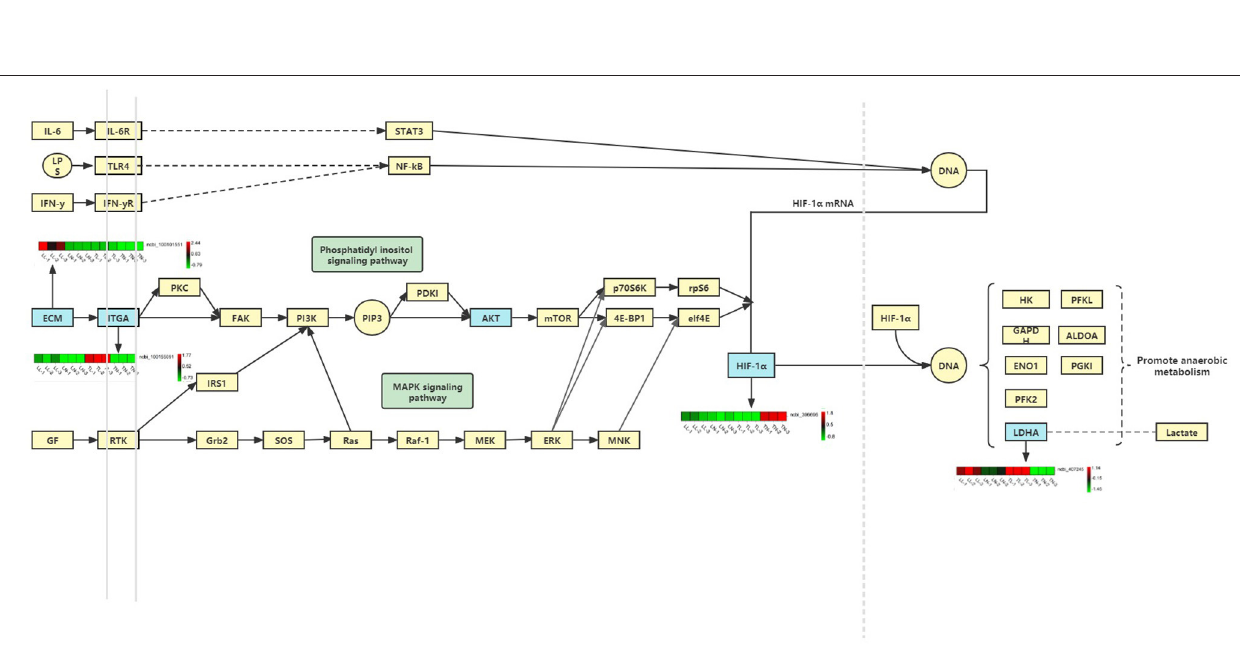
Frontiers in Veterinary Science |